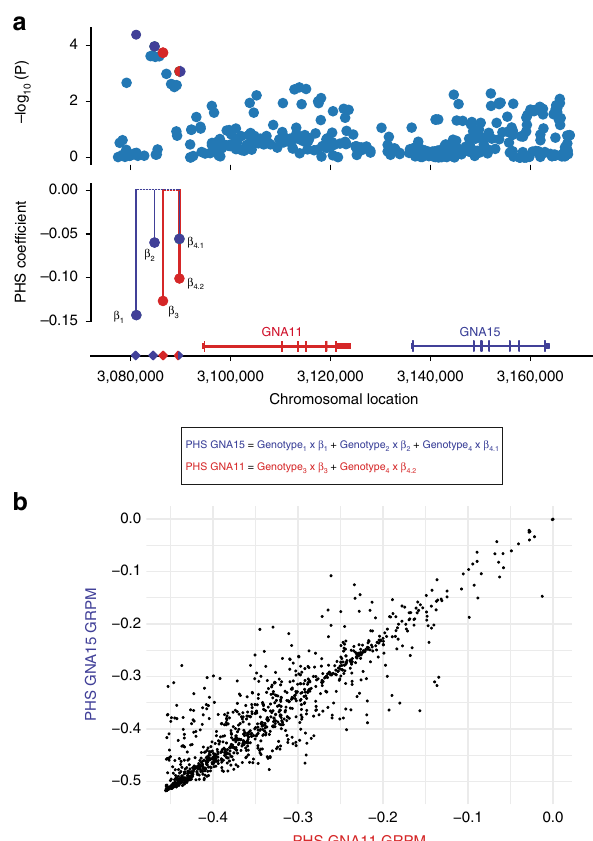
Fig. 4 Genomic region 19p13.3 with the two genes GNA11 and GNA15 . The two G-alpha signaling high-con fi dence germline-related prognostic modules (GRPMs) identi fi ed in the estrogen receptor (ER)-negative subtype have a shared genetic signal in the same genomic region. a Top: − log P ) for the association with survival ( y axis) of all variants in the 10 ( region 19p13.3 ( y axis). Bottom: regression coef fi cients from the survival model for the genetic variants in the module ’ s polygenic hazard scores (PHSs). b Scatter plot comparing the two modules ’ PHSs in the iCOGS independent validation set. PHS of the GNA11 GRPM on the x axis and PHS of the GNA15 GRPM on the y